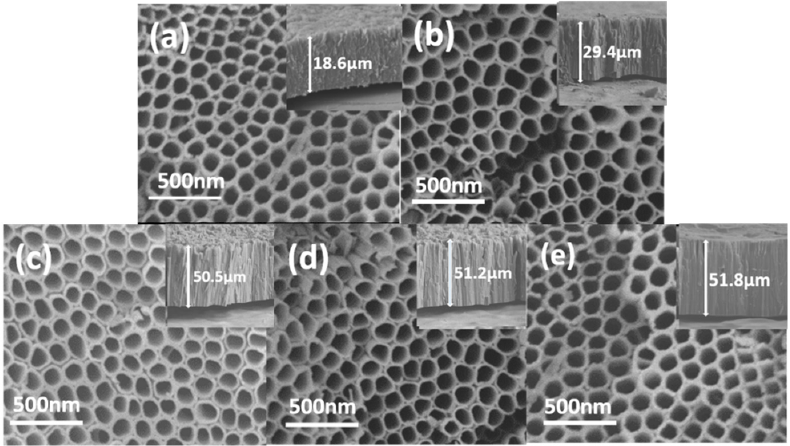
Figure 4. SEM images of TiO 2 nanotube arrays at different times. (a ) 6 h, ( b ) 8 h, ( c )10 h, ( d )12 h, and ( e )14 h.